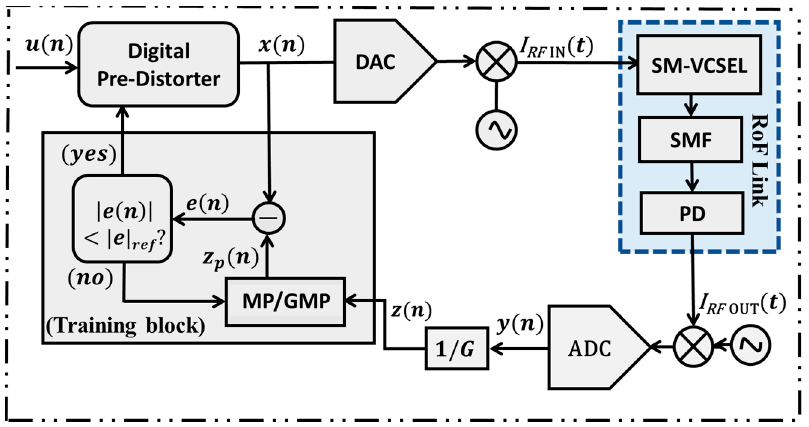
Figure 5. Schematic of indirect learning architecture for the Memory Polynomial (MP)/ Generalized Memory Polynomial (GMP)-based DPD methodology.